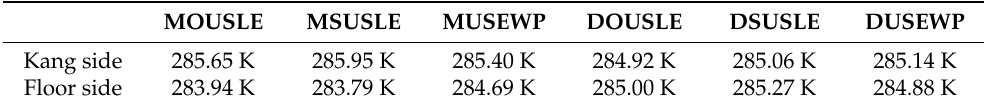
Table 6. The average temperature of the air on the kang side and the floor side when the ventilation volume is Q = 141 m 3 /h.